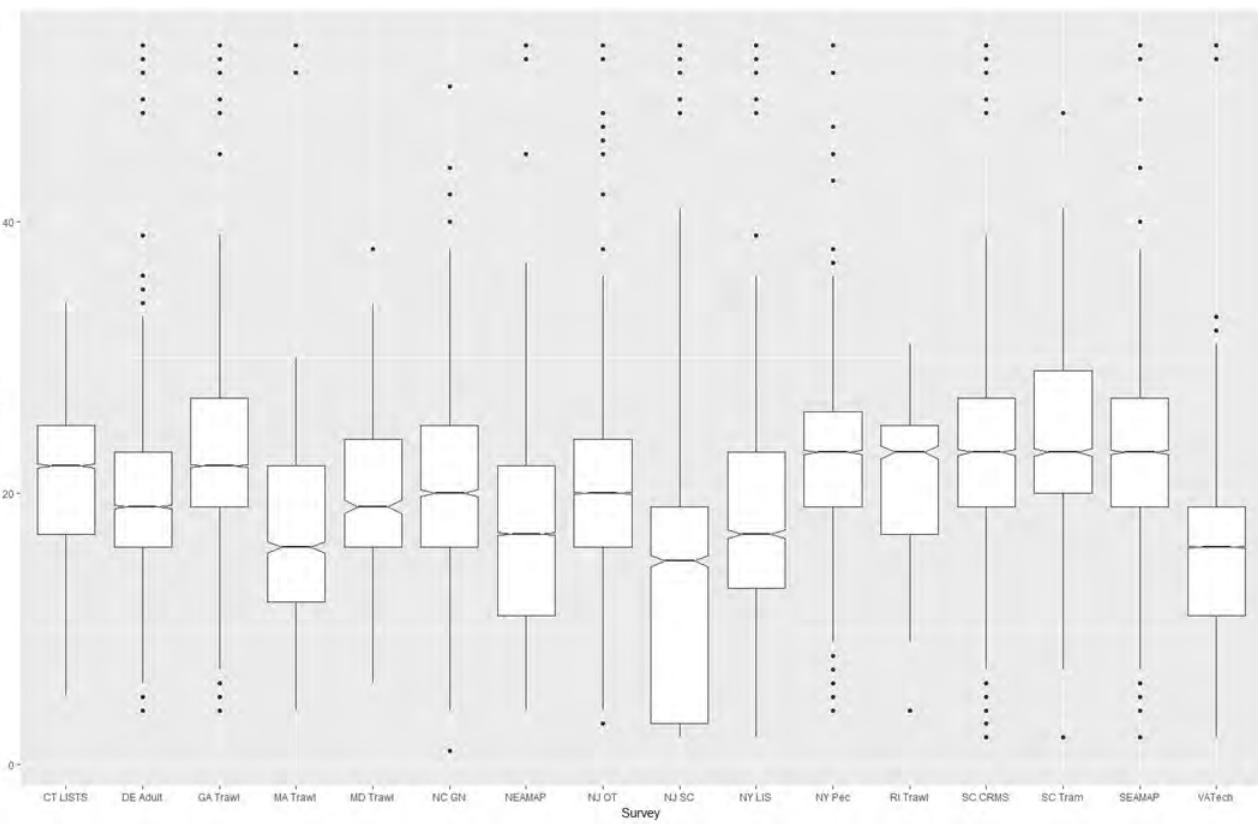
Figure 22. Boxplot of horseshoe crab prosomal widths (cm) caught in each fishery independent survey used in this